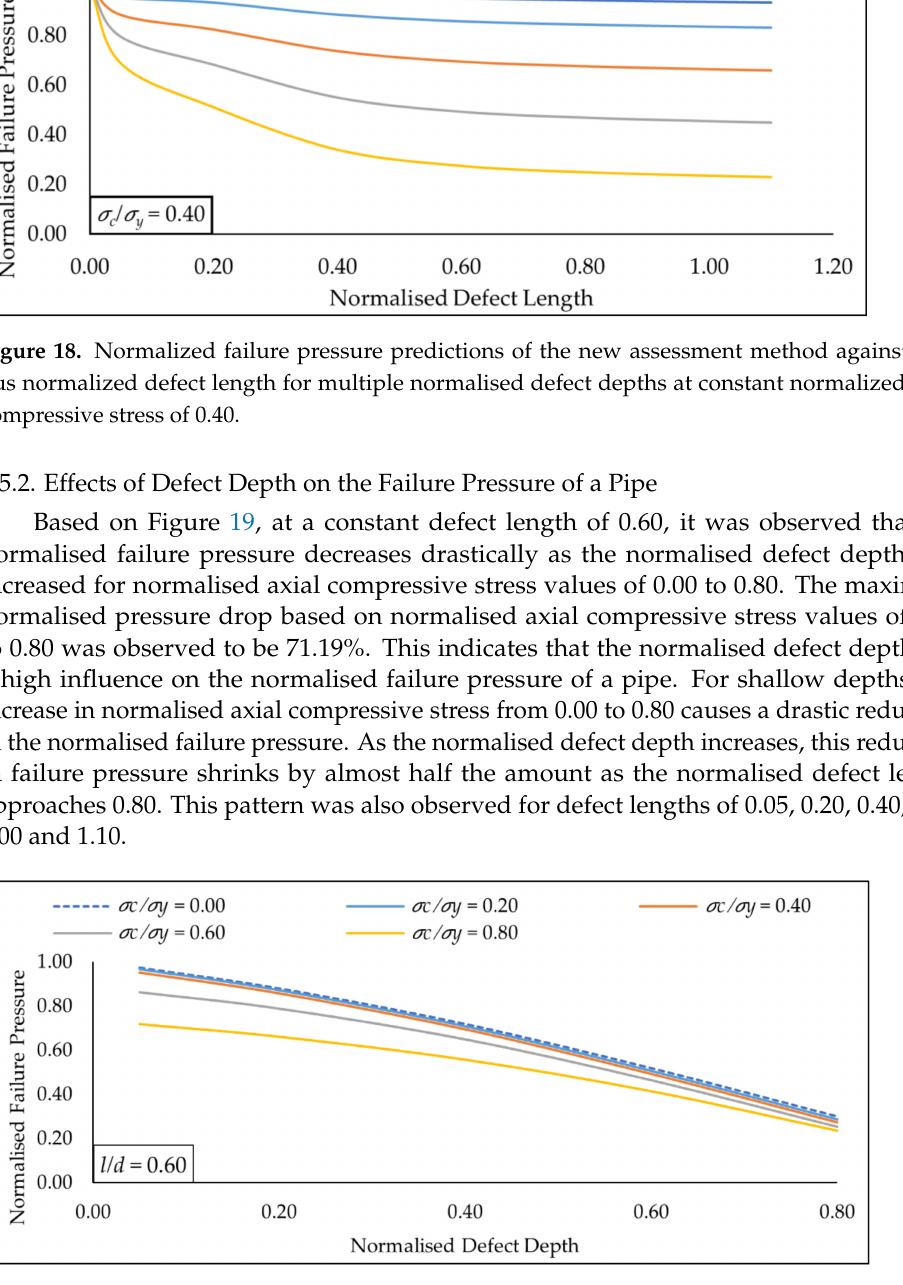
Figure 19. Normalized failure pressure predictions of the new assessment method against various normalized defect depth for multiple axial compressive stress at constant normalized defect length of